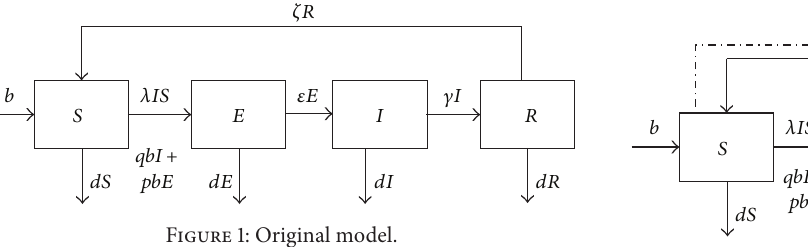
Figure 1: Original model.